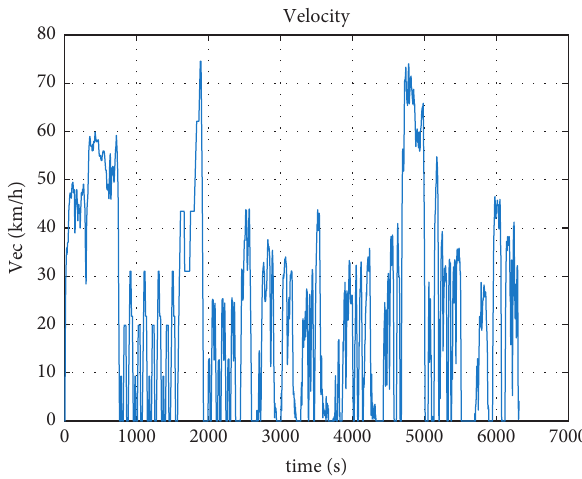
Figure 12: Training sample with multiple driving cycles. Table 2: RMSE between single basic predictor and integrated predictor. Integrated predictor 1.0009 Table 3: RMSE between actual result and predictive result in each second. The sample second in the prediction